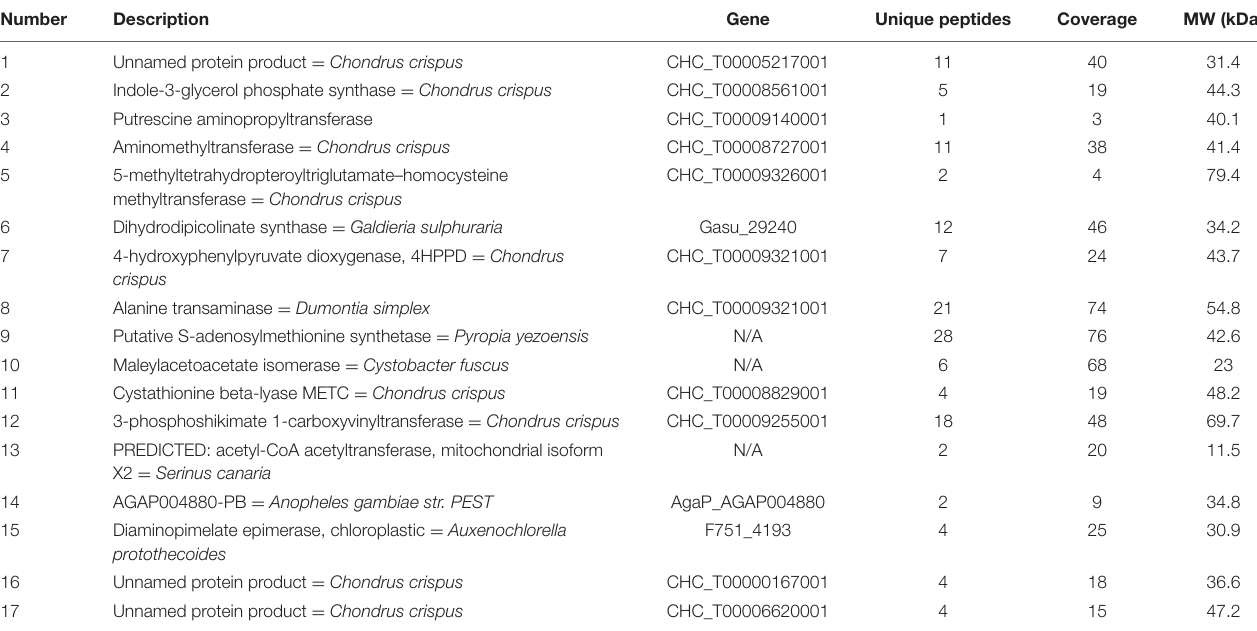
TABLE 1 | Amino acid metabolism protein.